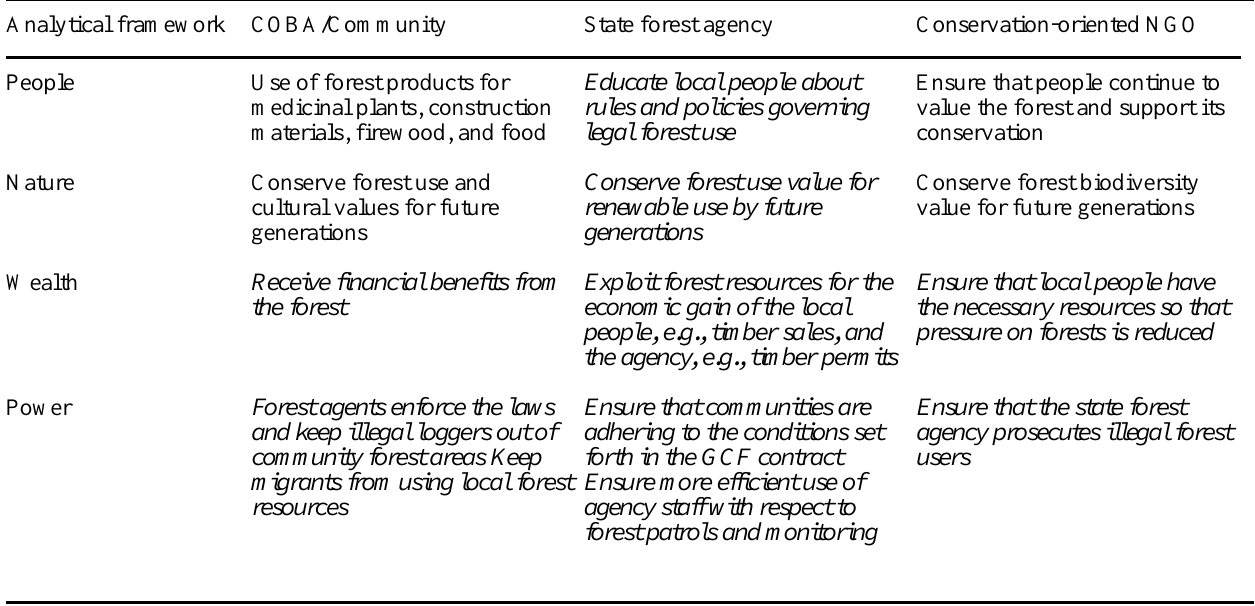
Table 1 . Interests held by various Gestion Contractualisée des Forêts (GCF) parties related to People, Nature, Wealth, and Power. Italics indicate interests that are not met by the current GCF contracts in Menabe. COBA is an acronym for community-level forest